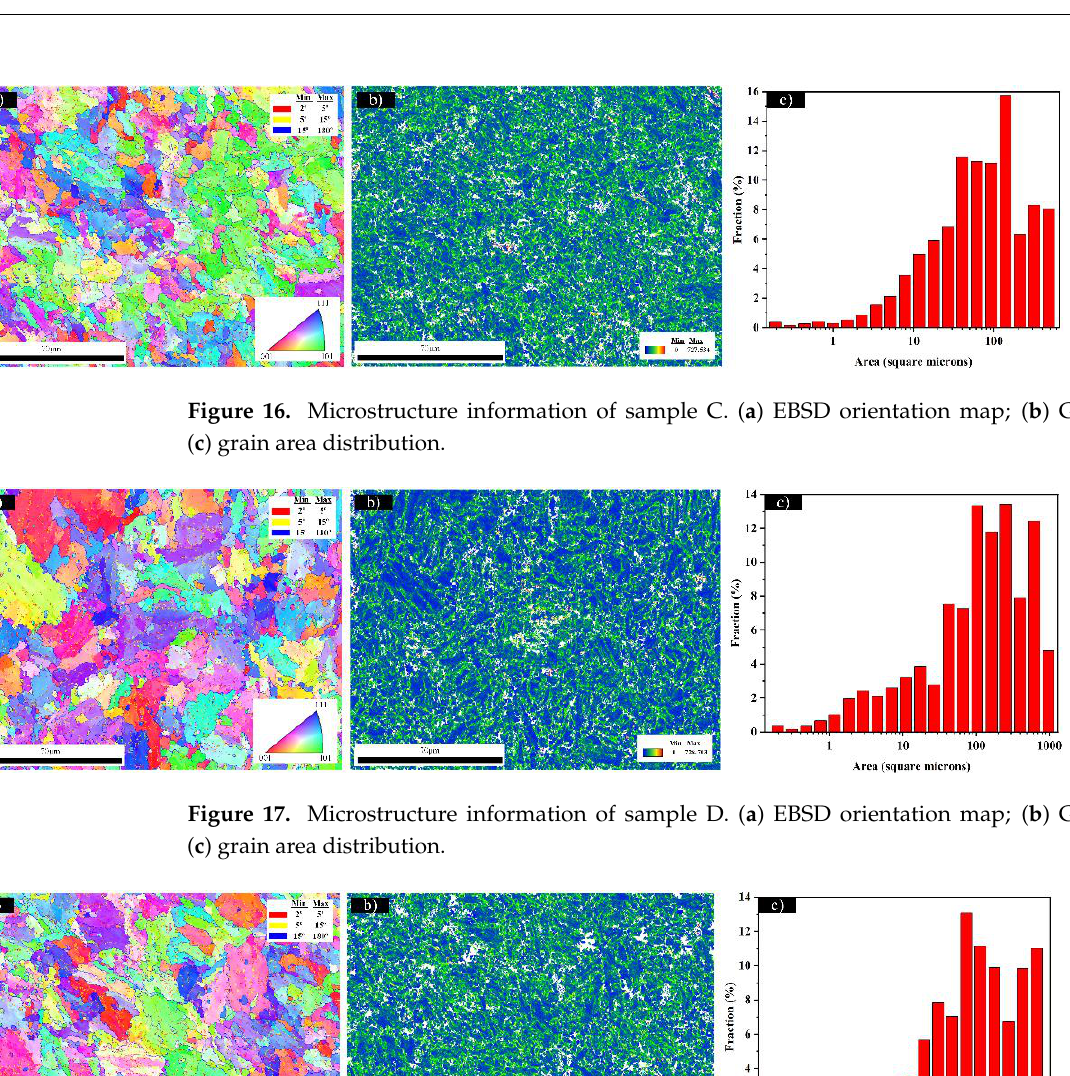
Figure 15. Microstructure information of sample B. ( a ) EBSD orientation map; ( b ) GND map; ( c ) grain area distribution.